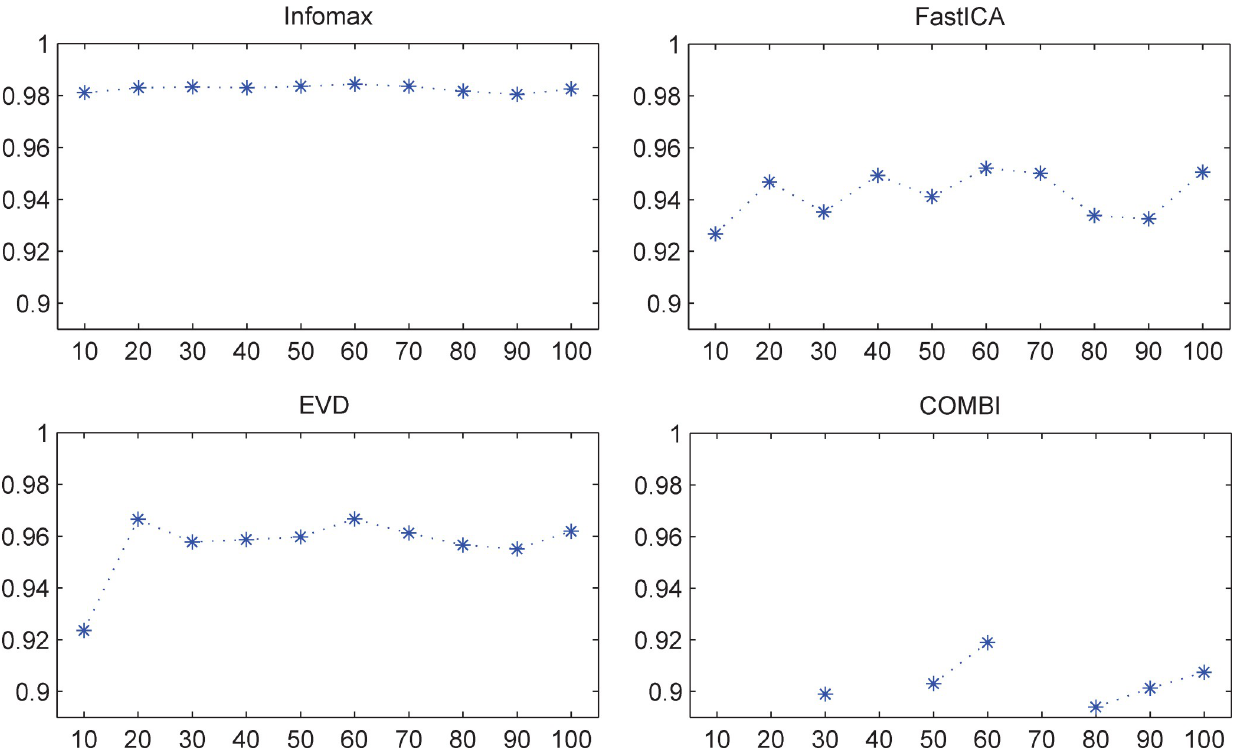
Fig 1. Median Iq values of different results for non-deterministic ICA (sensory data). The unit of the x-axis is the ICASSO repetition number k , and the unit of the y-axis is the Iq value. The results of COMBI presented clusters containing only one estimate when k = 10, 20, 40, and 70; under such conditions, the corresponding Iq value could not be calculated, which suggested very poor reliability.